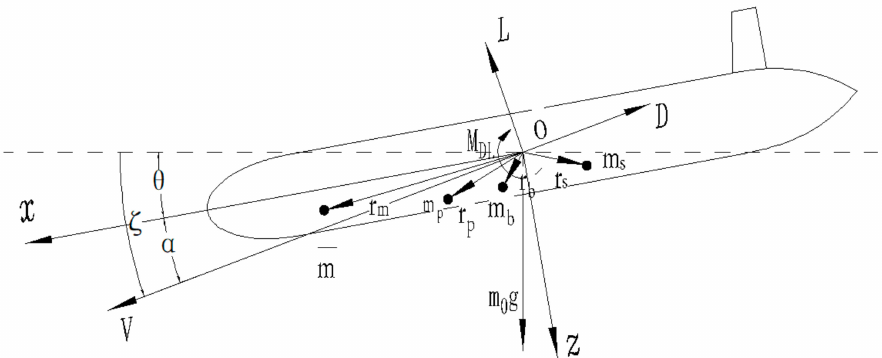
Figure 5. Force diagram of the